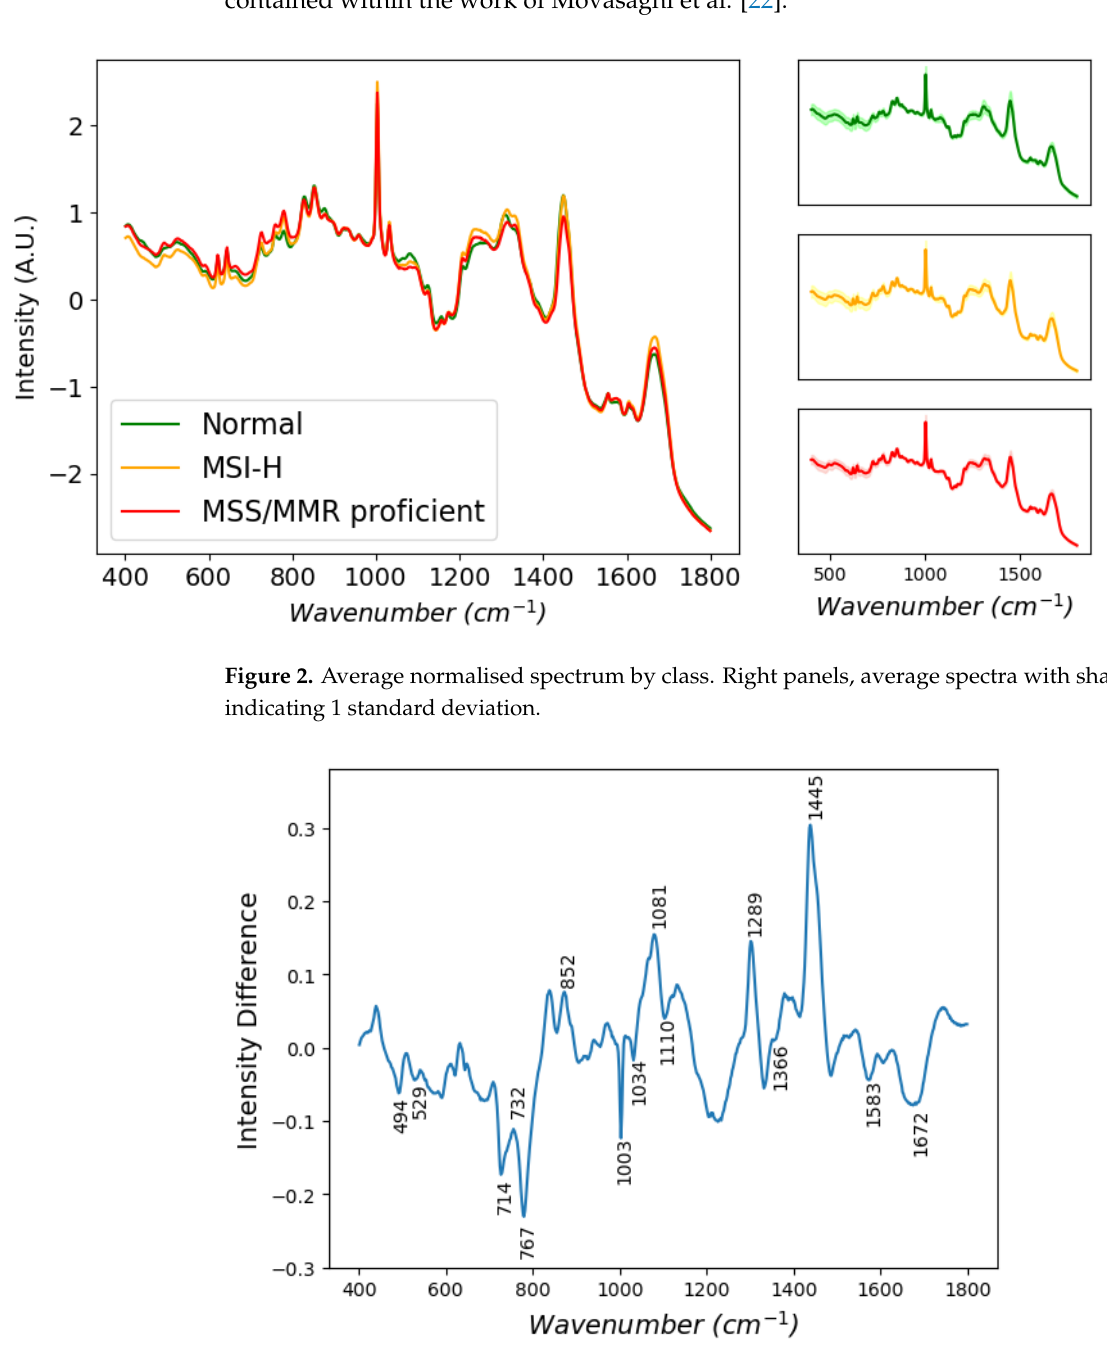
Figure 3. Difference spectrum: MSI-H minus MSS. Numbers indicate peaks mentioned in the